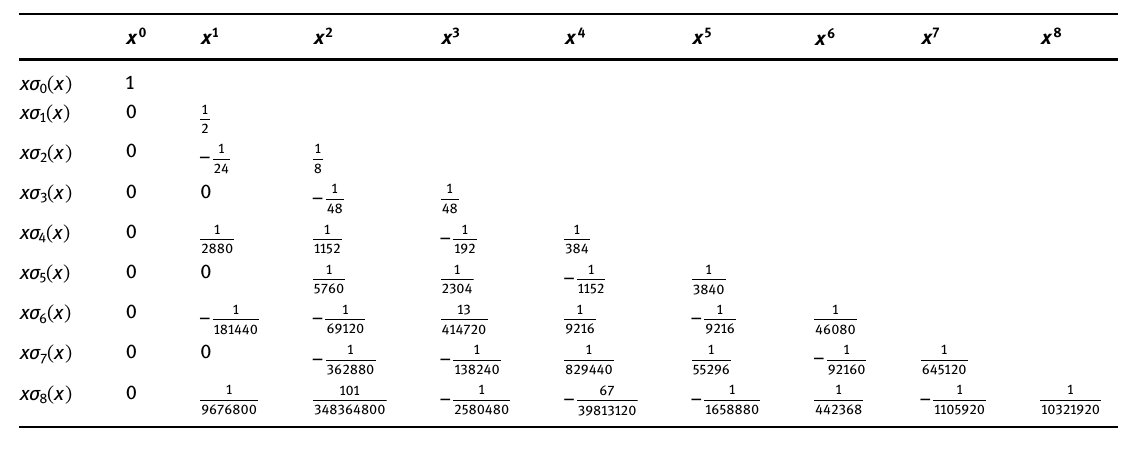
Table 1: Coe ffi cients of the fi rst few polynomials